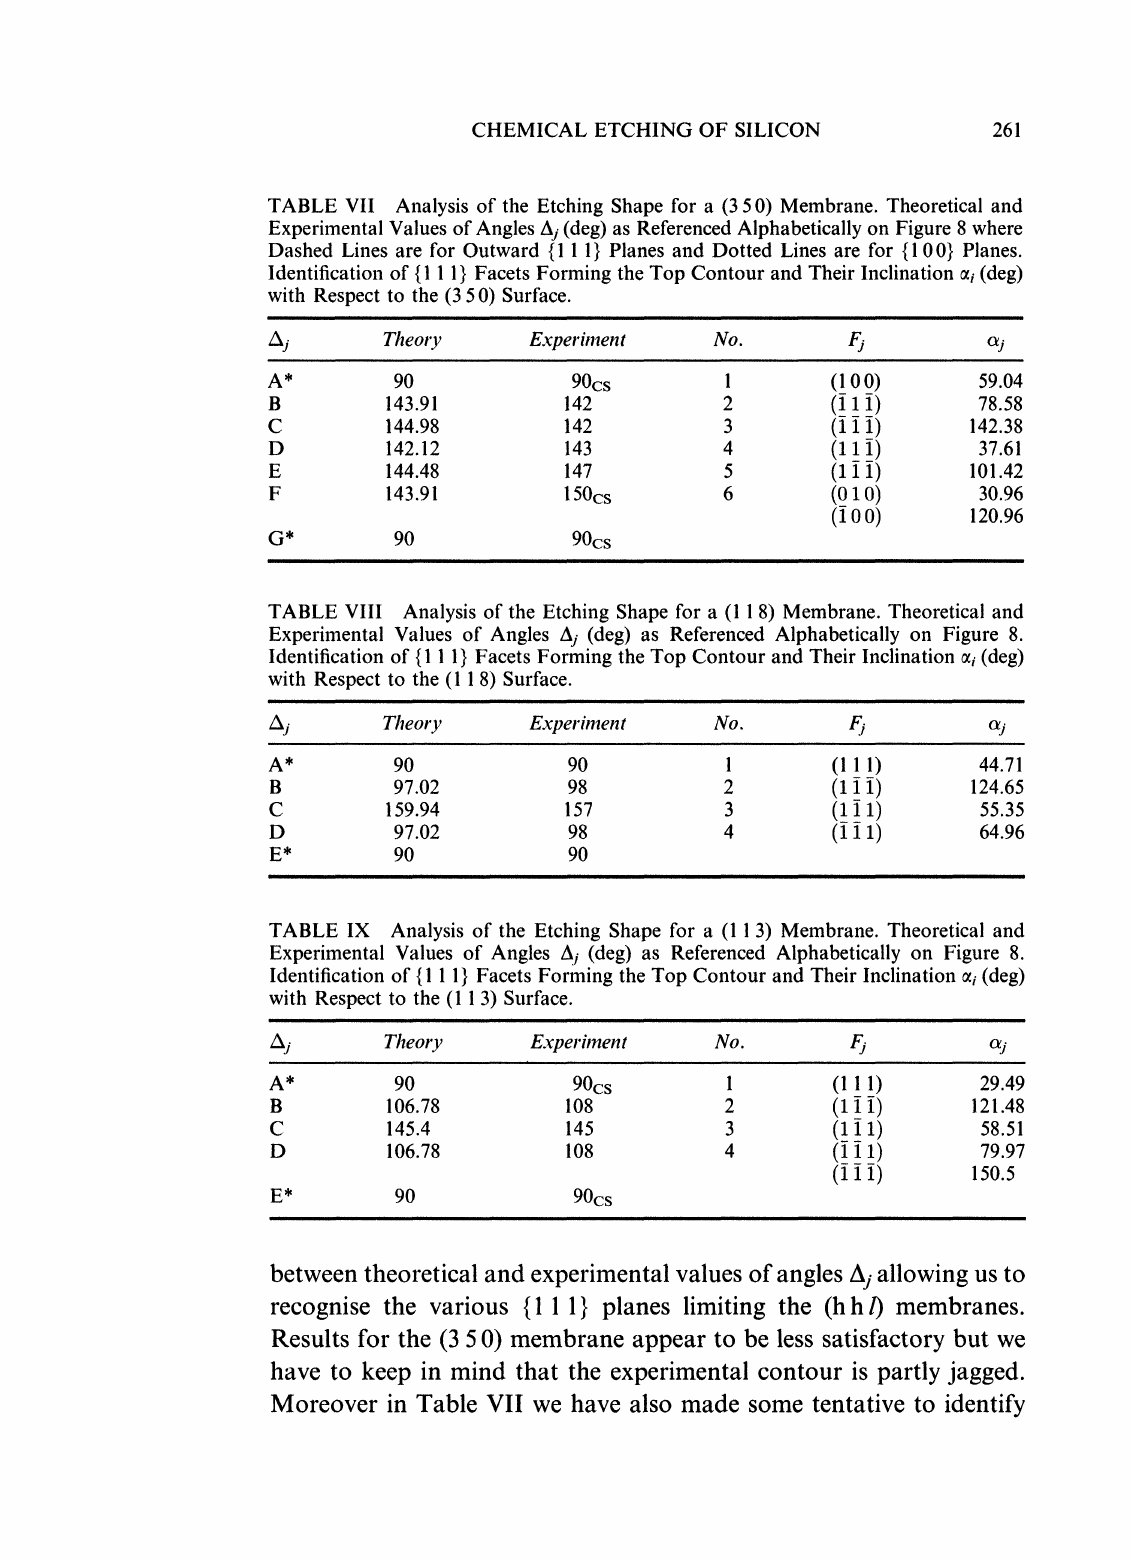
TABLE IX Analysis of the Etching Shape for a (1 3) Membrane. Theoretical and Experimental Values of Angles Ai (deg) as Referenced Alphabetically on Figure 8. Identification